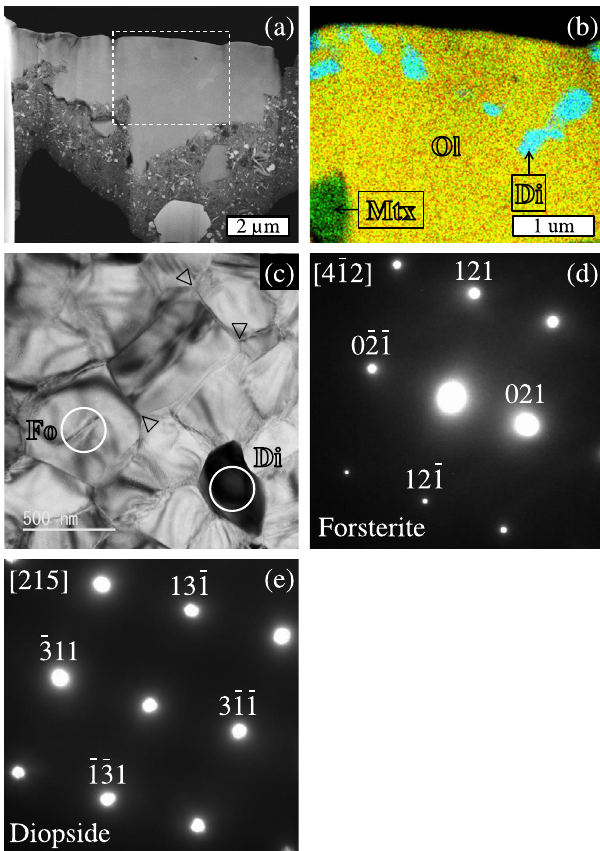
Fig.2|Sub-micronstructuresofC0040-02-Chd.a Ahigh-angleannulardark- fi eld (HAADF)-STEM image of the FIB section from C0040-02-Chd, b a combined ele- mental map in Mg (red), Si (green), and Ca (blue) X-rays of a rectangle area drawn with the dashed line in panel ( a ), c a bright fi eld (BF)-TEM image of olivine and diopside in an area of C0040-02-Chd, and d , e selected-area electron diffraction (SAED) patterns from forsterite along the [4 (cid:1) 12] zone axis and diopside along the [215]zoneaxis.Abbreviationsinpanel( b ):Ol,olivine;Di,diopside;Mtx,matrix.The 120° triple junctions are indicated by the vertex of an open triangle in panel ( c ). Circled areas in panel ( c ) represent analysis spots of electron diffraction on for- sterite (Fo) and diopside (Di).